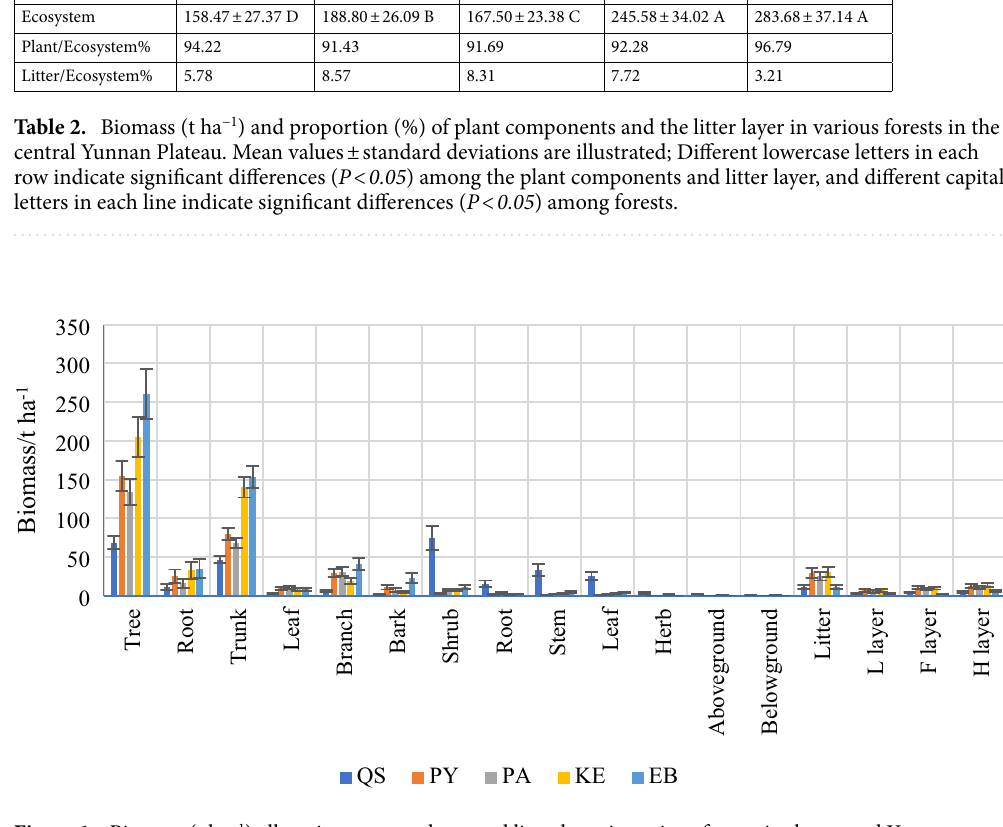
Figure 1. Biomass (t ha −1 ) allocation among plants and litter layer in various forests in the central Yunnan Plateau. Error bars mean standard